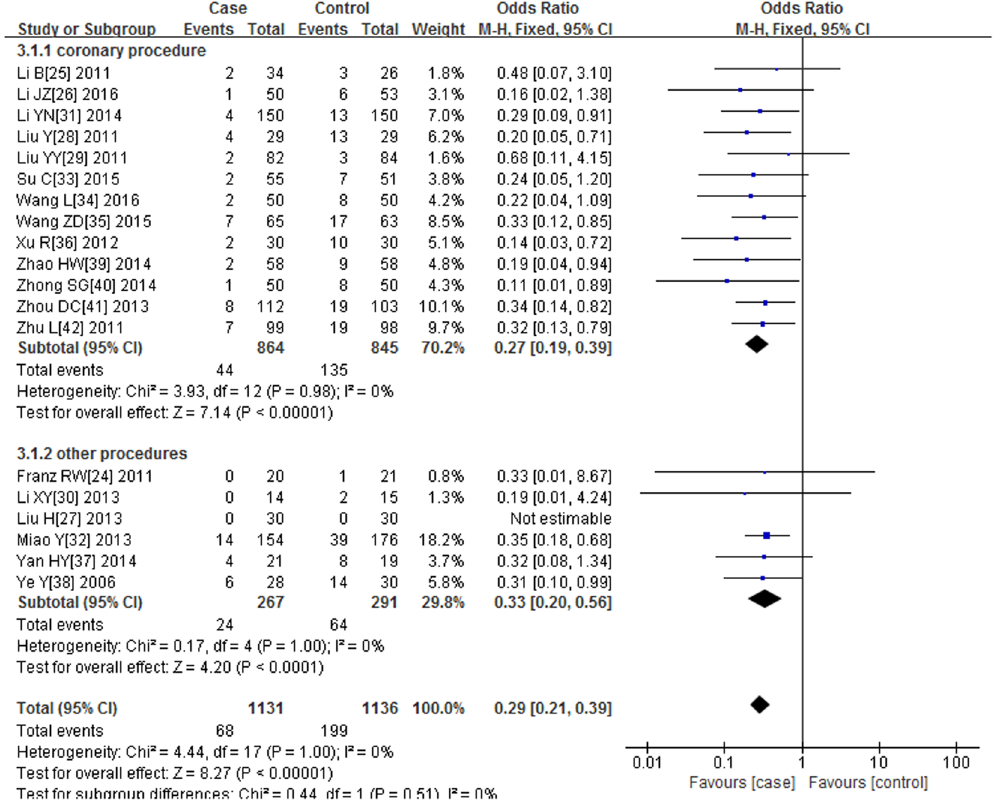
Figure 2. Forest plot of the association between using of alprostadil and the incidence of CIN, the horizontal lines correspond to the study-specific OR and 95% CI, respectively. The area of the squares reflects the study- specific weight. The diamond represents the pooled results of OR and 95%